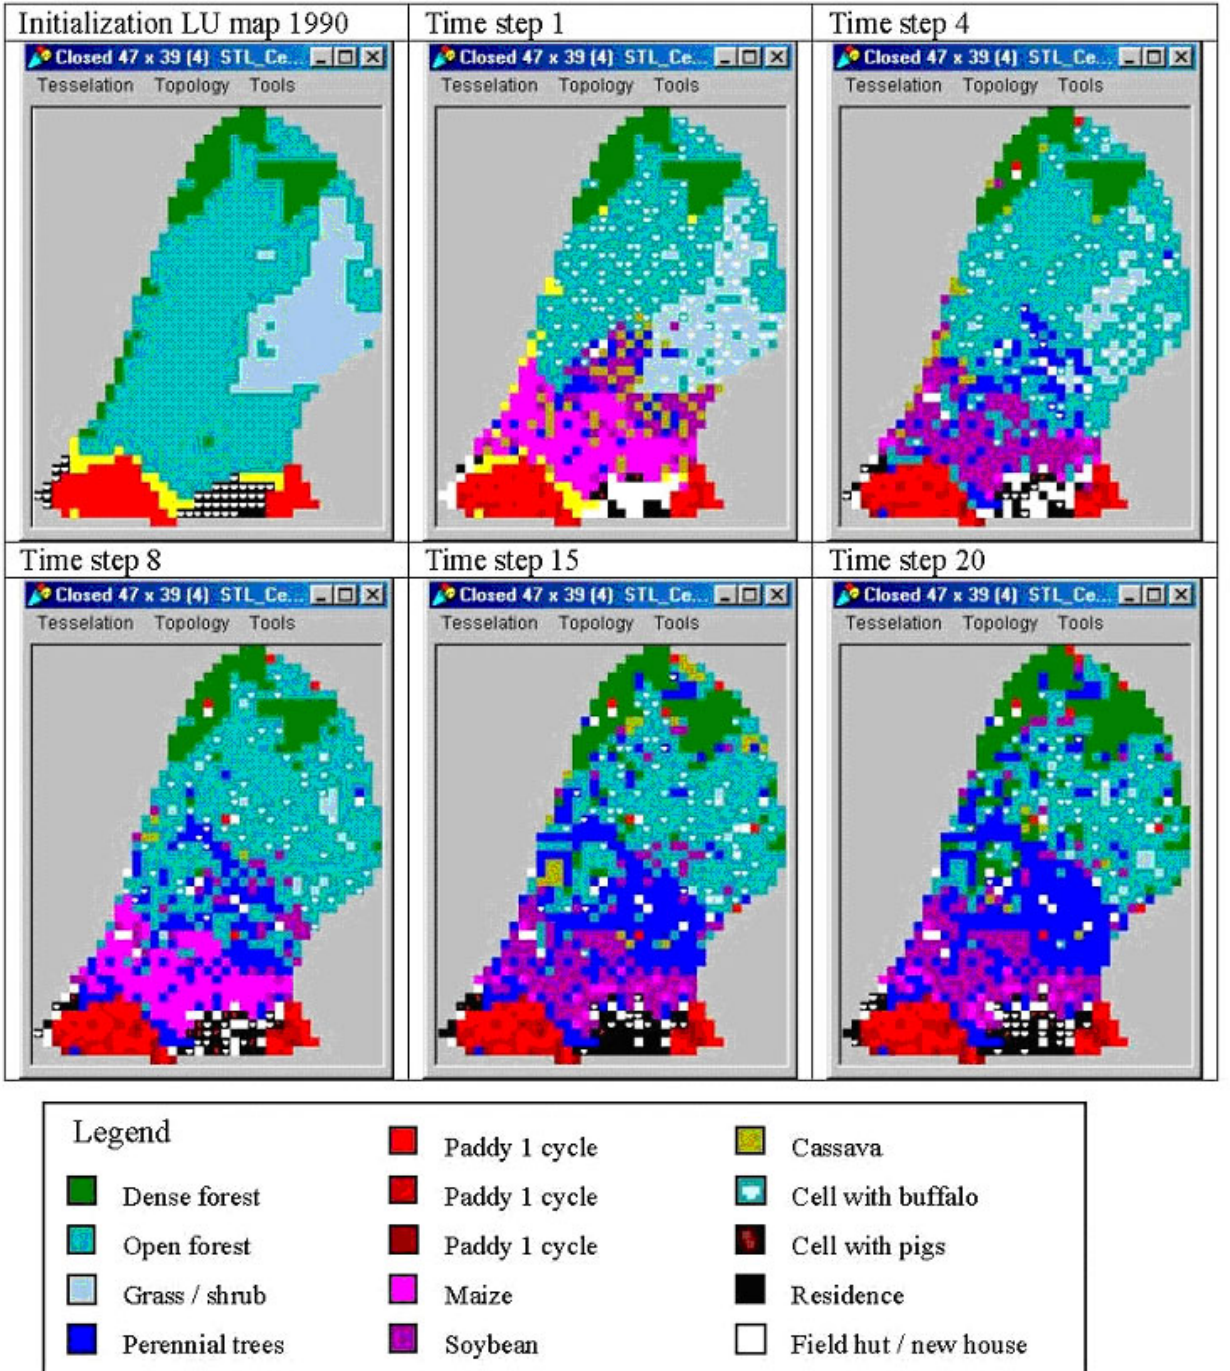
Fig. A2-2. Evolution of land use/land cover near Thon 2A village in Tan Lap commune at successive time steps of the simulation, with symbols of livestock agents overlaid on the